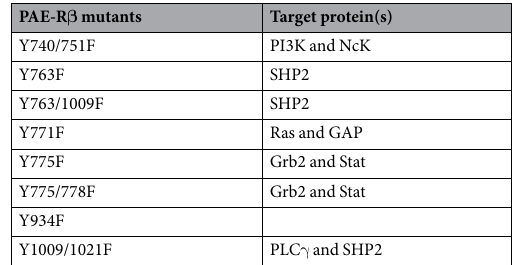
Table 1. List of PAE-R β mutants. List of PAE-R β mutants and the signaling protein(s) that their mutated PDGF-R β receptor cannot interact with upon receptor